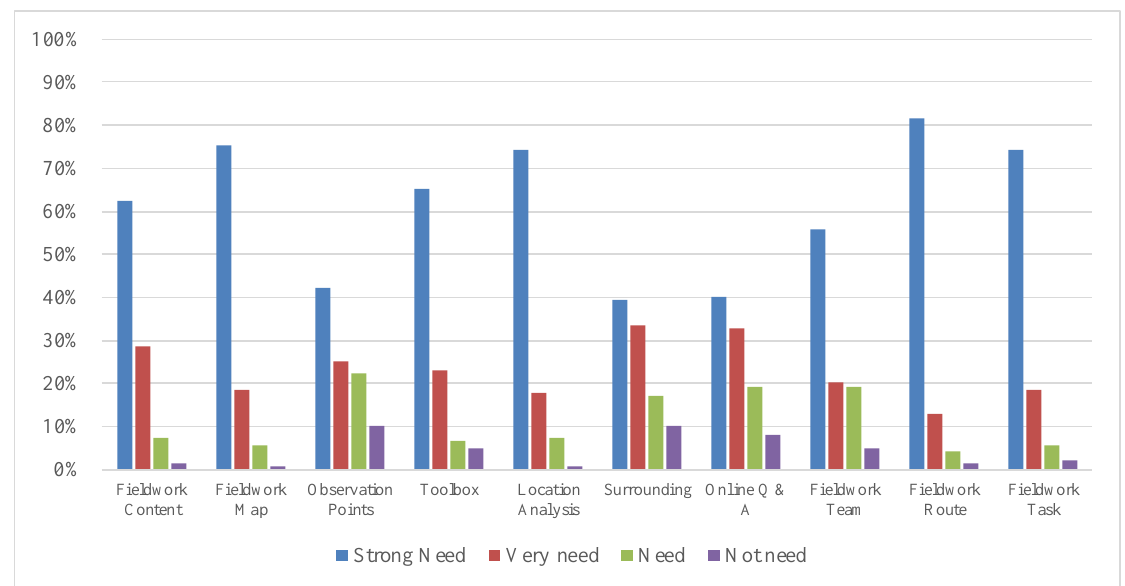
Figure 6. The demand for common functional modules in the whole process of the fieldwork.